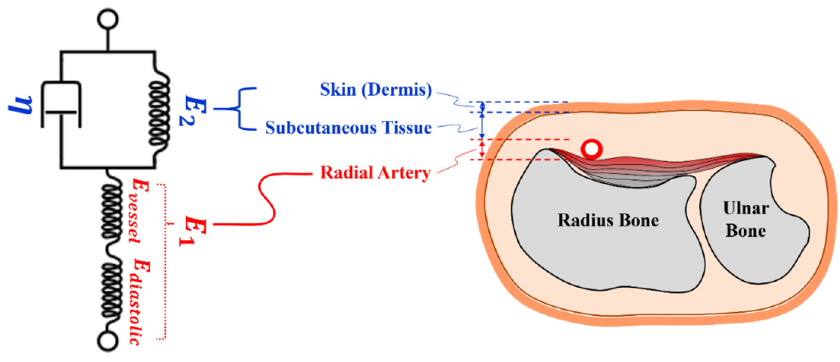
Figure 6. An illustration of spring-dashpot based Kelvin–Voigt model for human wrist. The two-layer Kelvin–Voigt model for the skin and the vessel discussed above can be expressed as a differential equation (see Equation (1)). In the equation, σ is stress and ϵ is strain. The values of the parameters 𝐸 (cid:2869) , 𝐸 (cid:2870) , and 𝜂 need to be determined experimen- tally to solve the equation.